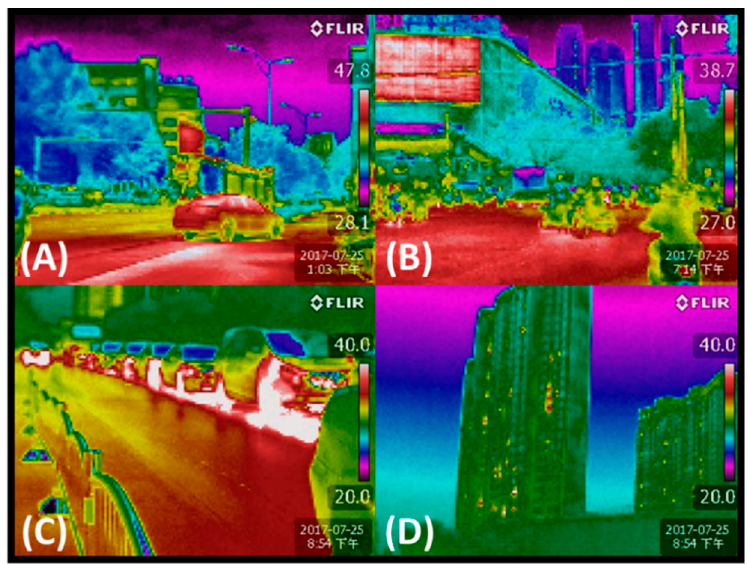
Figure 12. Infrared thermography of the Er-qi commercial district ( A , B ) and the Yanzhuang residential district ( C , D ).